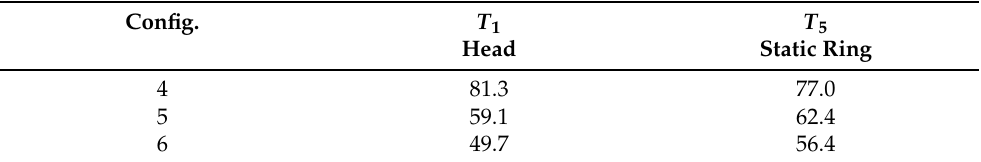
Table 5. Anti-icing evaluation initial values for the probe head and the static ring containing test data from configurations 4, 5 and 6 in [ ◦ C]. Config. T 1 T 5 Head Static Ring 4